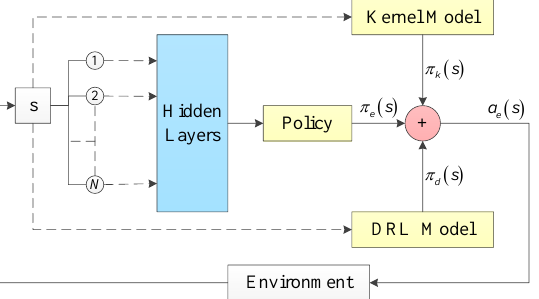
Figure 12. Architecture of the deep ensemble multi-agent RL. Reprint from [40].